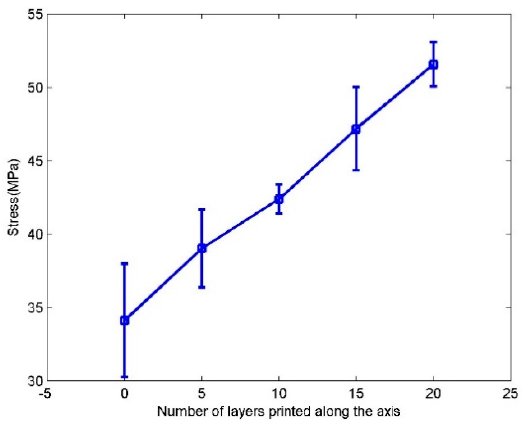
Figure 22. Tensile test the maximum stress of each group.